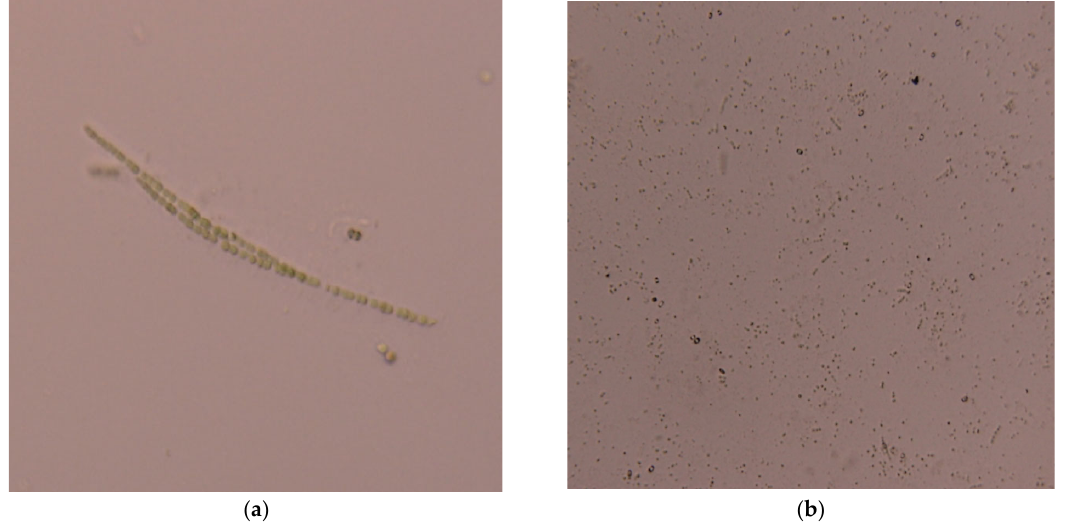
Figure 3. Blue-green algae microscope image (( a ) before blue-green algae eradication—non-disrupted blue-green algae; ( b ) after blue-green algae eradication—blue-green algae after the disruption of clusters).